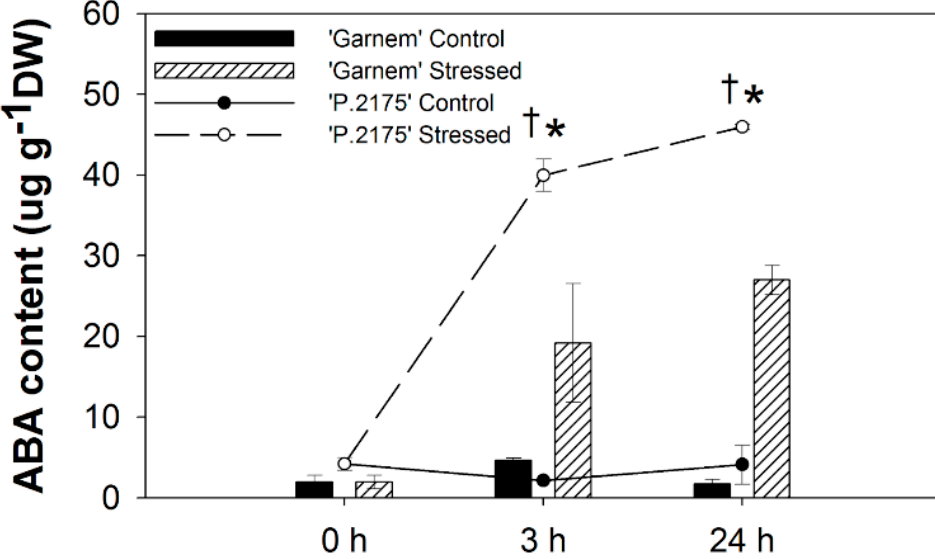
Figure 2. Abscisic acid (ABA) content during the drought experiment. Error bars represent the standard error of the mean. (MS = dried weight). *: significant differences ( p ≤ 0.05) following the Student’s t -test between genotypes (‘Garnem’ vs. Myrobalan ‘P.2175’) for each time point of the experiment (0 h–3 h–24 h); †: significant differences ( p ≤ 0.05) following the Student’s t -test between treatments (control vs. drought stress) for each time point of the experiment. h = hour.